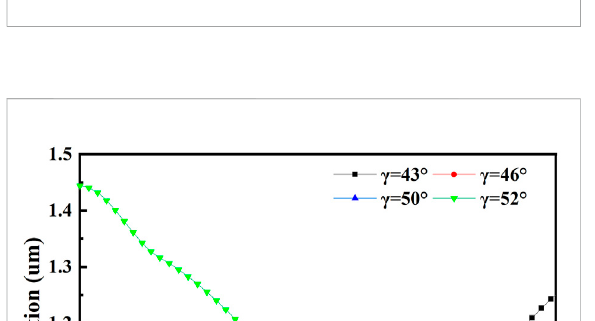
FIGURE 12 Deformation of tooth heads with different correction angles under temperature load.